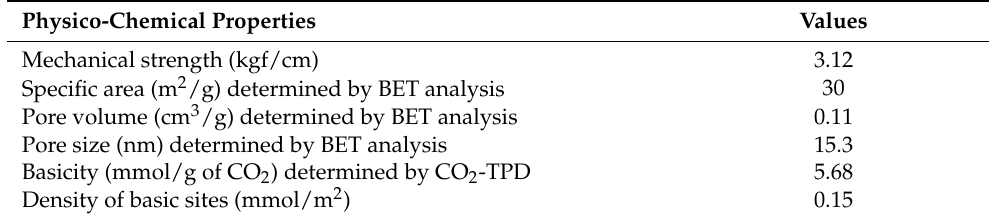
Table 1. Physico-chemical properties of the prepared catalysts from K 2 CO 3 / γ -Al 2 O 3 / Sepiolite/CoFe 2 O 4 .